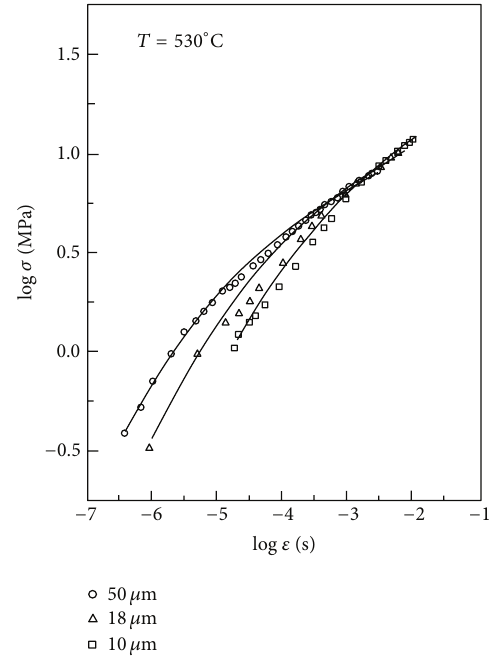
Figure 10: The effect of grain size on the flow